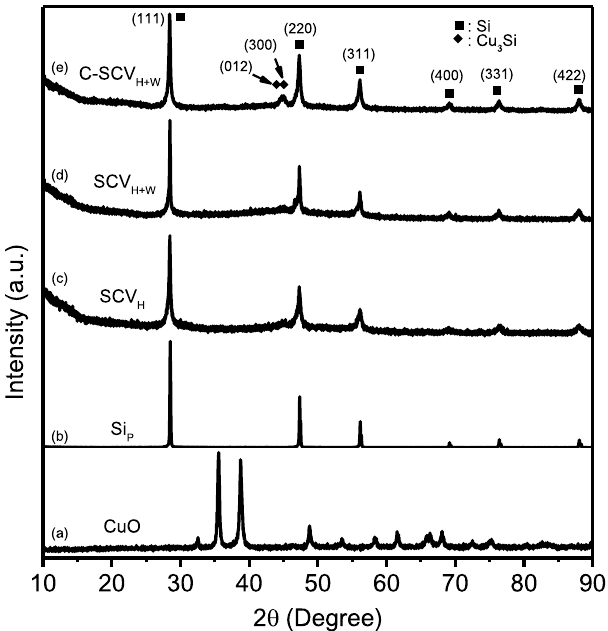
Figure 4. X-ray diffraction patterns of the ( a ) CuO, ( b ) Si P , ( c ) SCV H , ( d ) SCV H + W and ( e ) C-SCV H + W